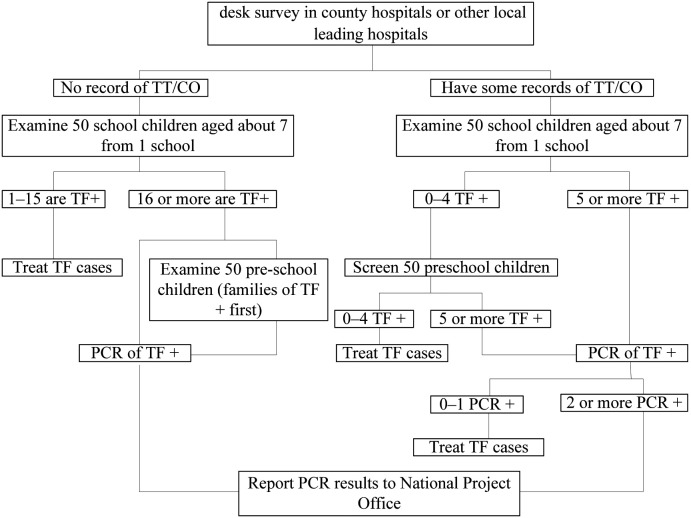
Flow path for TRA.